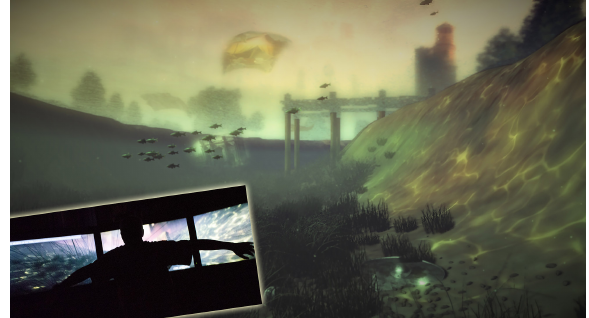
Figure 3. Virtual Museum of the Tiber Valley . Underwater scenario